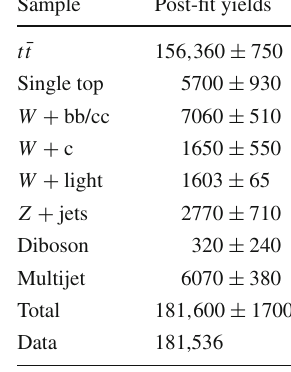
Sample Post-fit yields